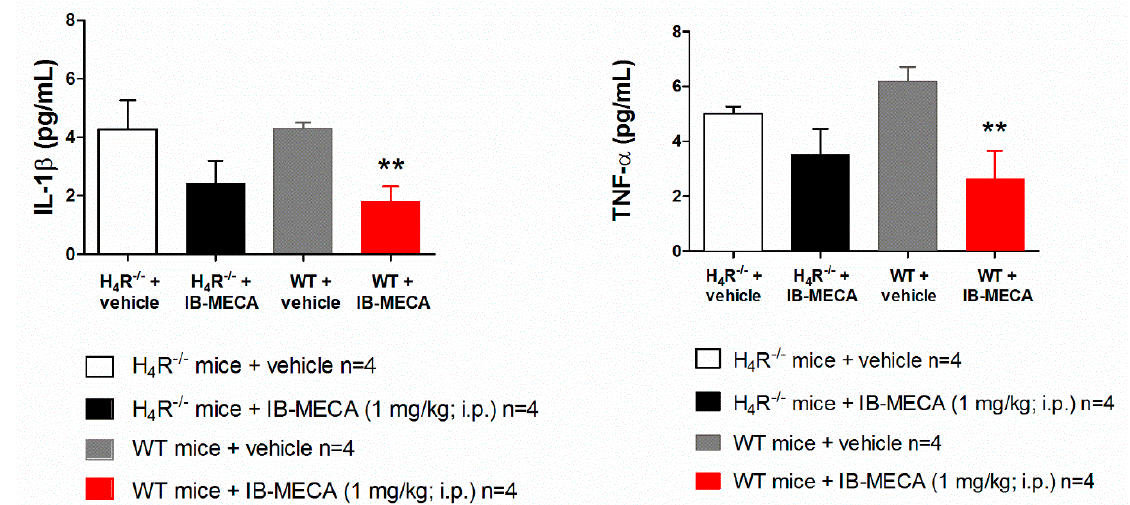
Figure 3. Effect of A 3 AR agonist IB-MECA on IL-1 β and TNF- α plasma levels on CCI-induced neuropathic pain in WT and H 4 R − / − mice. Sciatic nerve ligation was performed in WT and H 4 R − / − mice 8 days before the acute injection of IB-MECA (1 mg/kg, i.p.). One hour after administration, blood was collected for dosing IL-1 β and TNF- α plasma levels. Data are mean ± SD for 4 mice per group; ** p < 0.01 vs. WT mice + vehicle by one-way ANOVA with Dunnett’s test.